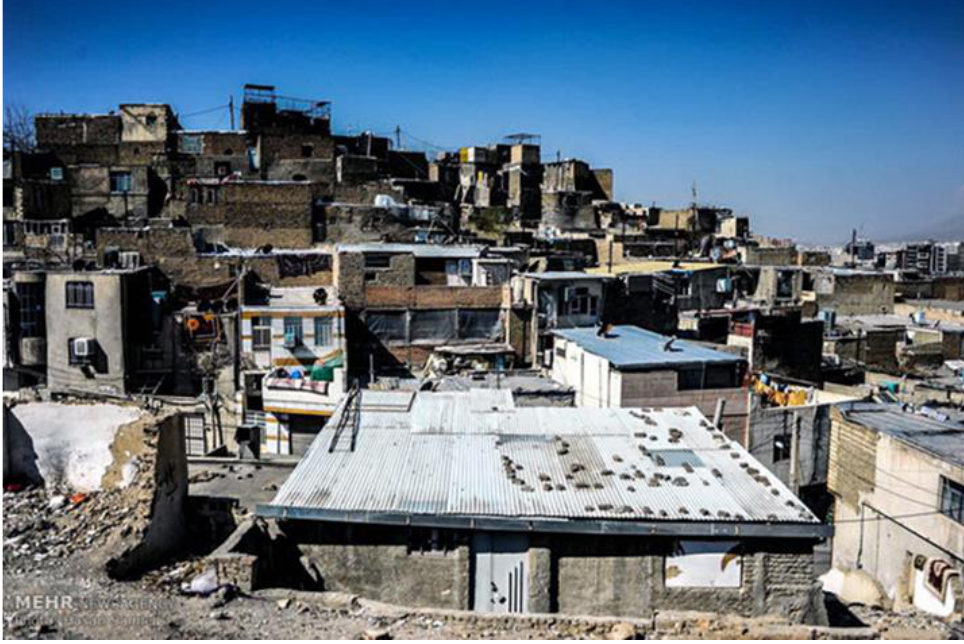
Fig.4: Karaj, View of Zurabad Neighborhood (Mehrnews, 2015 )